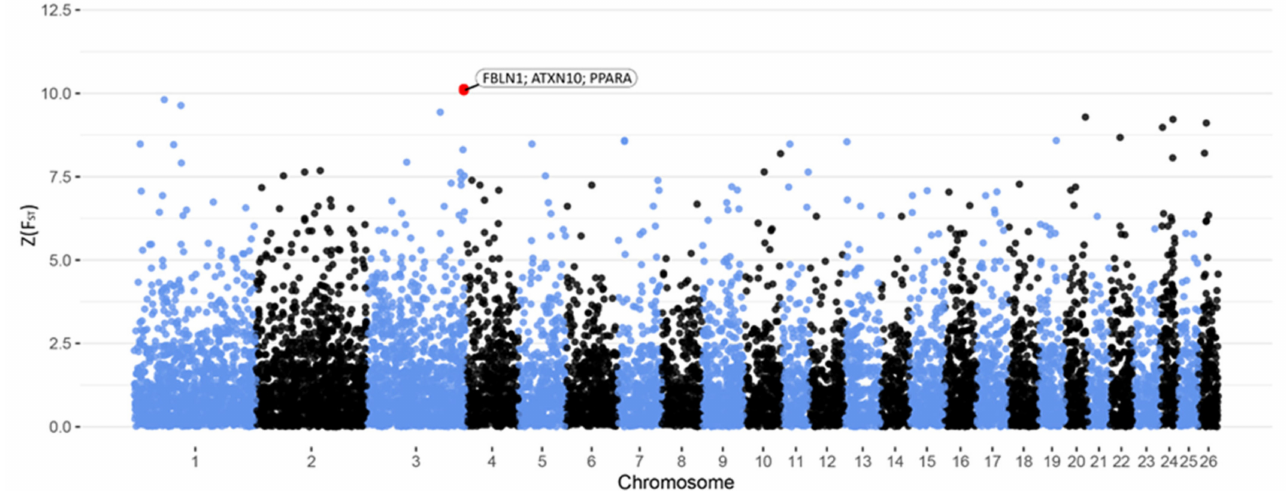
Figure 2. Manhattan plot of Z(F ST ) values at each SNP comparing LMQ and HMQ Barki ewes. The red dots represent the SNPs that passed the cut-off threshold at Z(F ST ) = 10 and are labelled with candidate genes within a 2 Mb